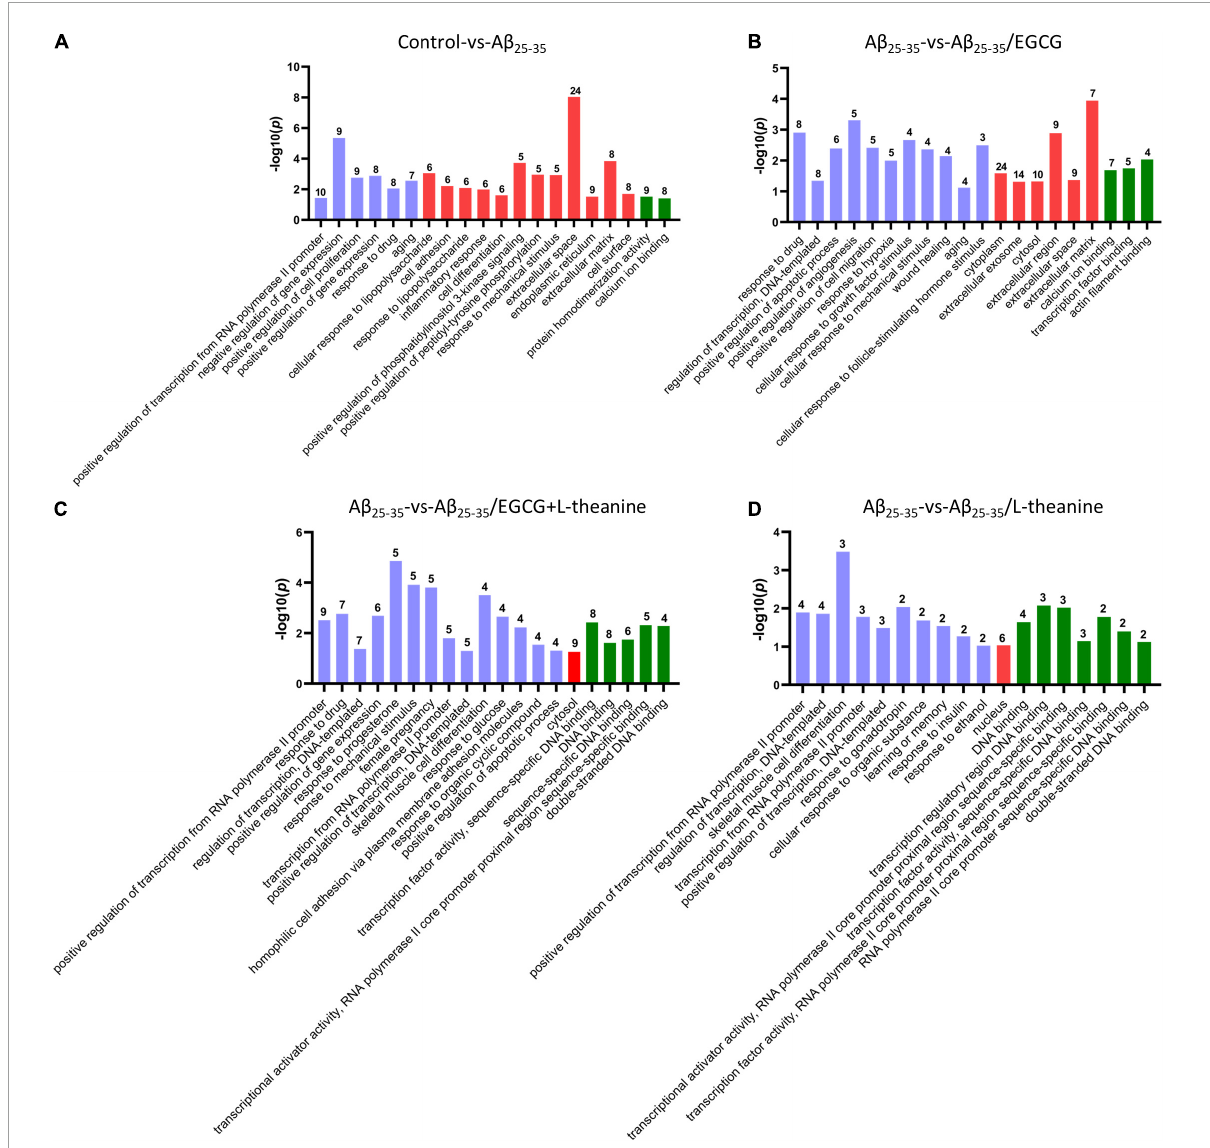
FIGURE7 GO enrichment analysis of differentiated genes (DEGs) in PC12 cells of different treatment groups. Graphs from panels (A–D) represent the GO analysis of Control-vs-A β 25 − 35 , A β 25 − 35 -vs-A β 25 − 35 /EGCG, A β 25 − 35 -vs-A β 25 − 35 /EGCG + L -theanine, and A β 25 − 35 -vs-A β 25 − 35 / L -theanine, respectively. The blue-purple, red, and green columns in the GO enrichment analysis diagrams represent the biological processes, cellular components, and molecular functions of cells in different treatment groups,